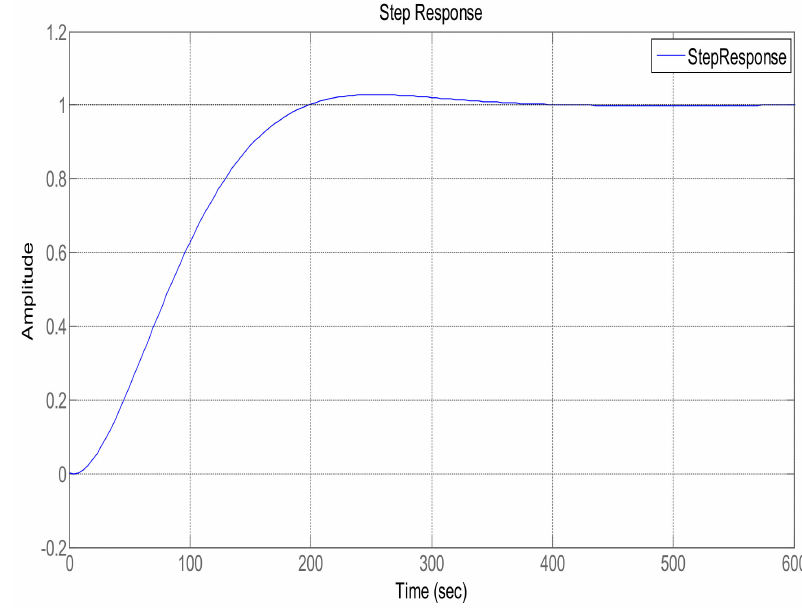
Figure 7. Step response using the PID